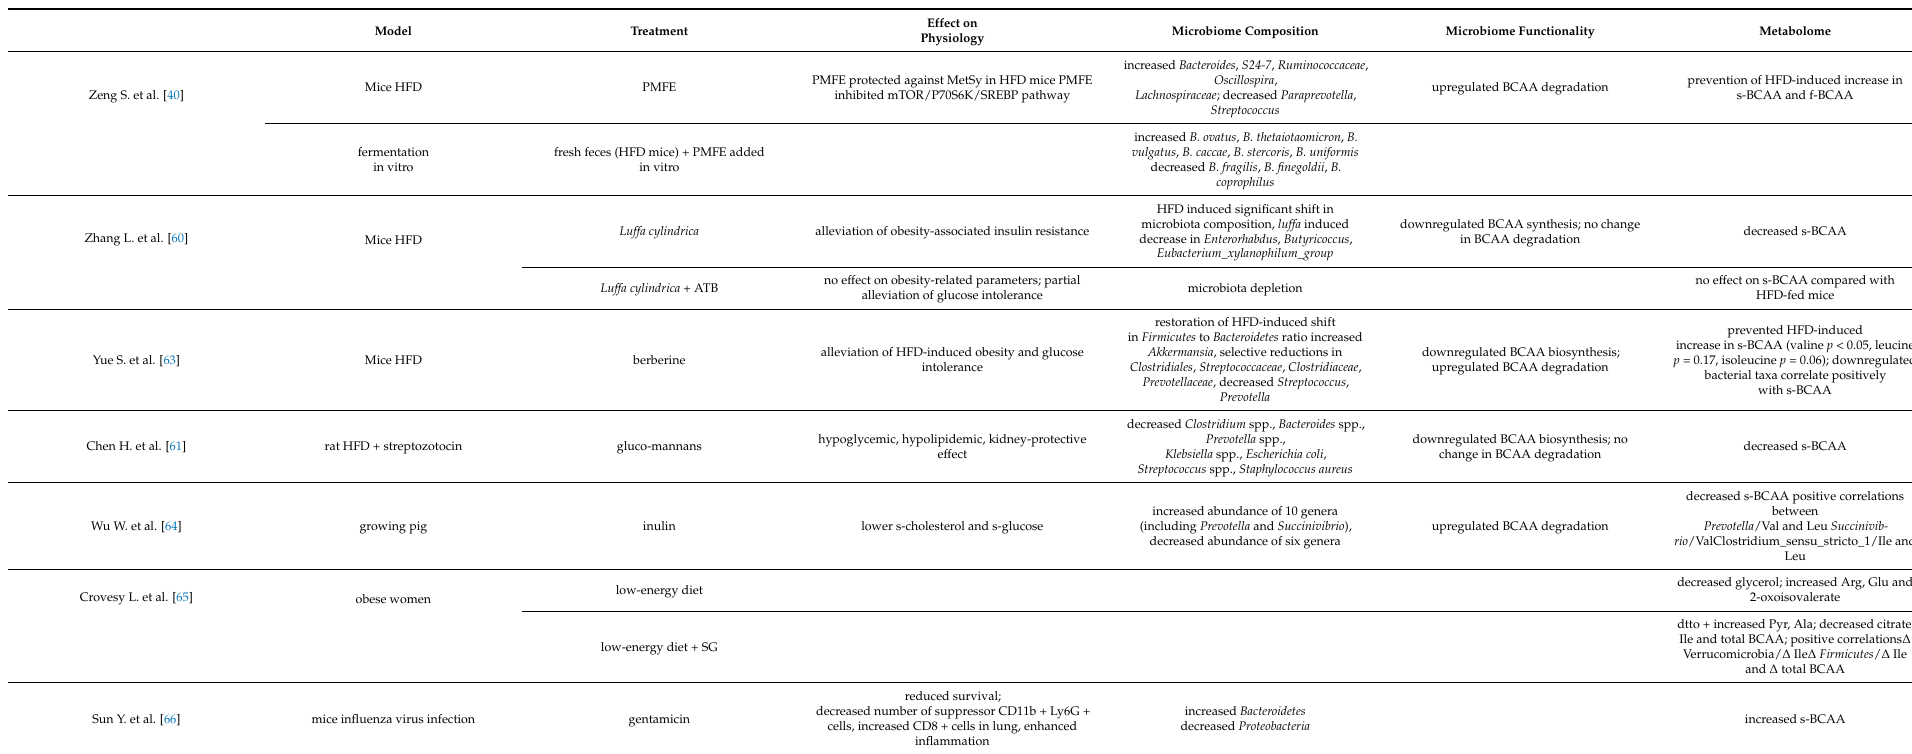
Table 4. The effect of microbiota modulation with phytochemicals or symbiotics on BCAAs concentration in